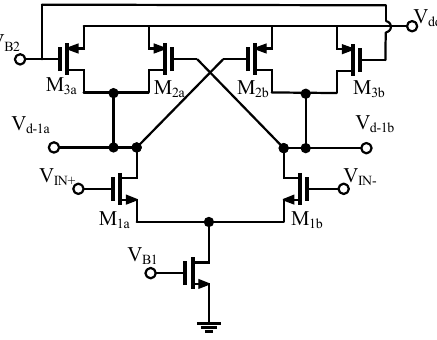
Figure 1. The differential pair of the proposed Schmitt trigger.